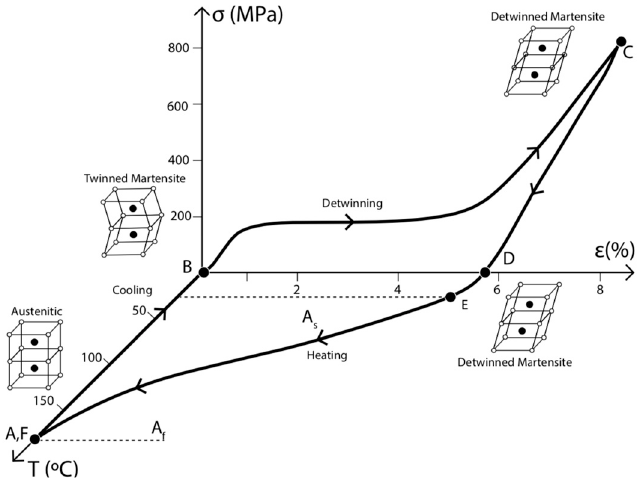
Figure 1. Phase diagram and stress-strain-temperature curve.